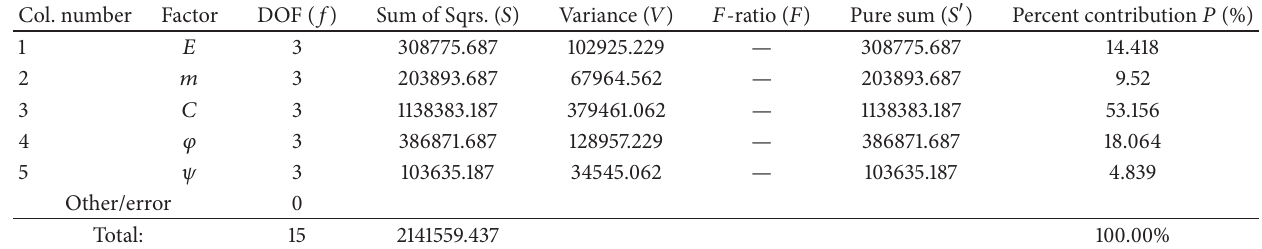
Table 7: Results of ANOVA table.